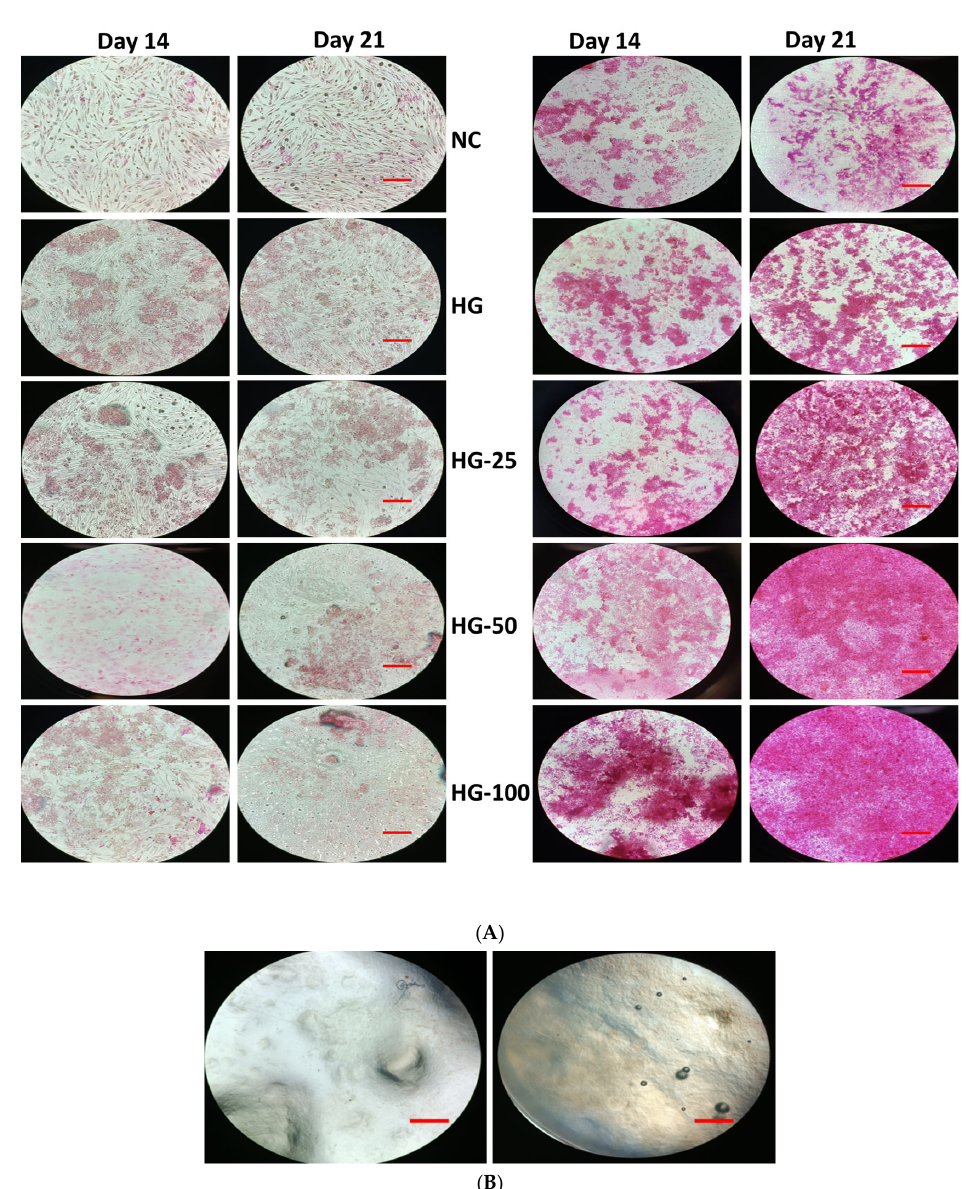
Figure 7. Alizarin red-S staining of osteogenic cells differentiated from MSC cultured on hydrogels for 14 and 21 days. Cells without osteogenic supplement ( Left ) and cells with osteogenic supplement ( Right ). ( A ) Cells cultured on hydrogels and stained, ( B ) only hydrogels with alizarin red S stain without cells and supplement. NC—cells without hydrogels, HG—hydrogels without VEGF, HG-25, -50, and -100—hydrogels with 25 ng/mL, 50 ng/mL, and 100 ng/mL of VEGF, respectively. Scale bar 10×—100 µm.